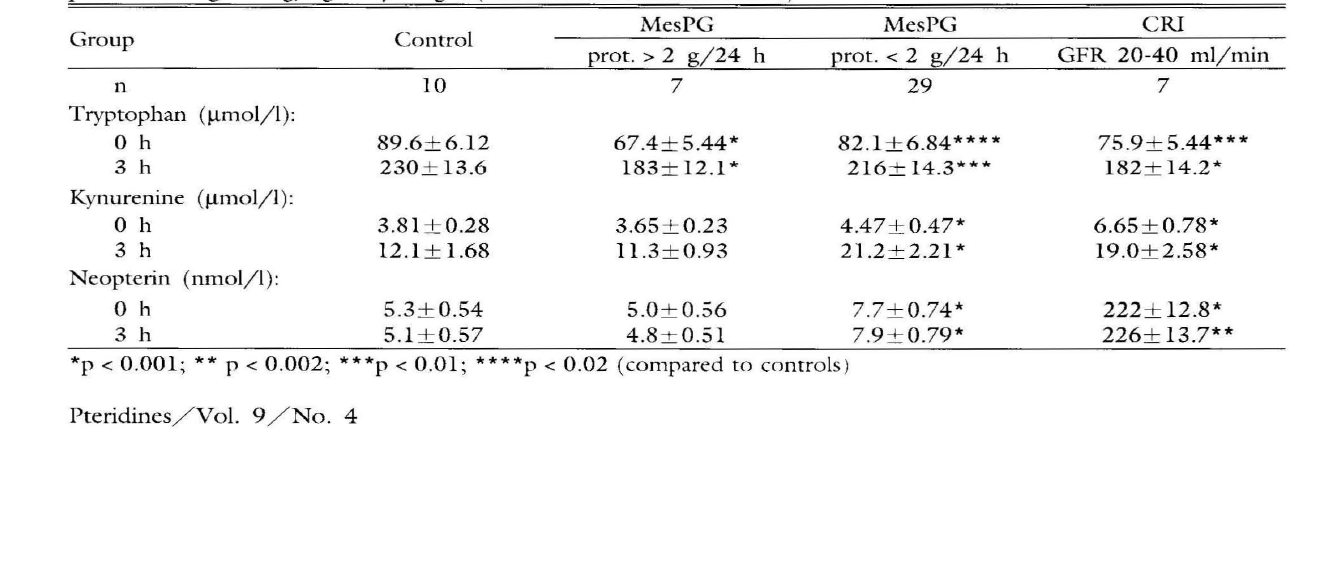
Table 1. Serum tryptophan, kynurenine and neopterin concentrations in the control group, in patients with mesan gioproliferative glomerulonephritis (MesPG) with proteinuria < 2 g/24 hand> 2 g/24 h, and in patients with chronic peroral loading 30 mg/ kg body weight (Mean values±S.D. are